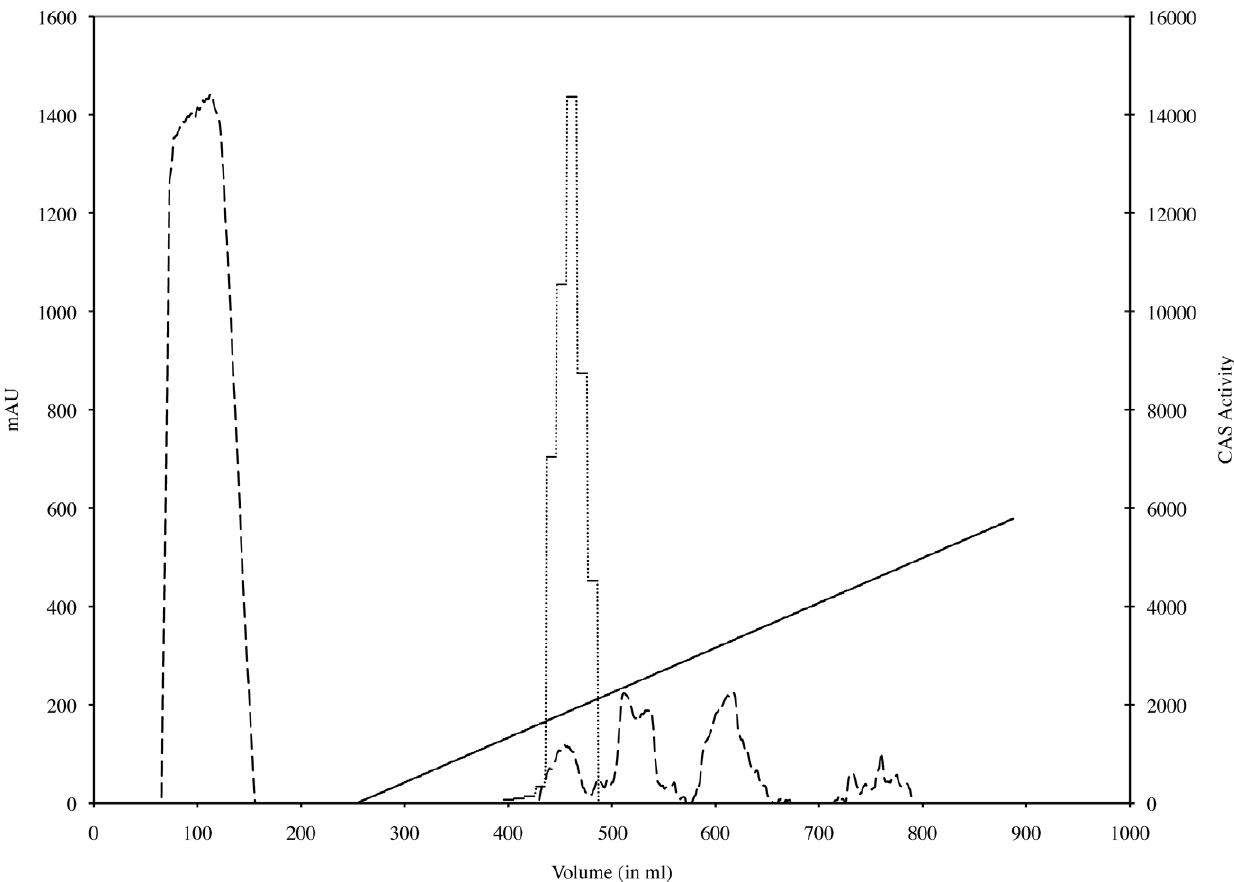
Figure 1. Final purification of corynebactin by C8 reversed-phase HPLC. Corynebactin was recovered as a single activity peak coincident with an A 210 absorbance peak at approximately 9.4% acetonitrile during elution with a 0% to 80% linear gradient of acetonitrile in 0.6% formic acid. A 210 is shown as a dashed line; the linear acetonitrile gradient is shown as a solid line; and CAS activity for each fraction is shown as a dotted line.